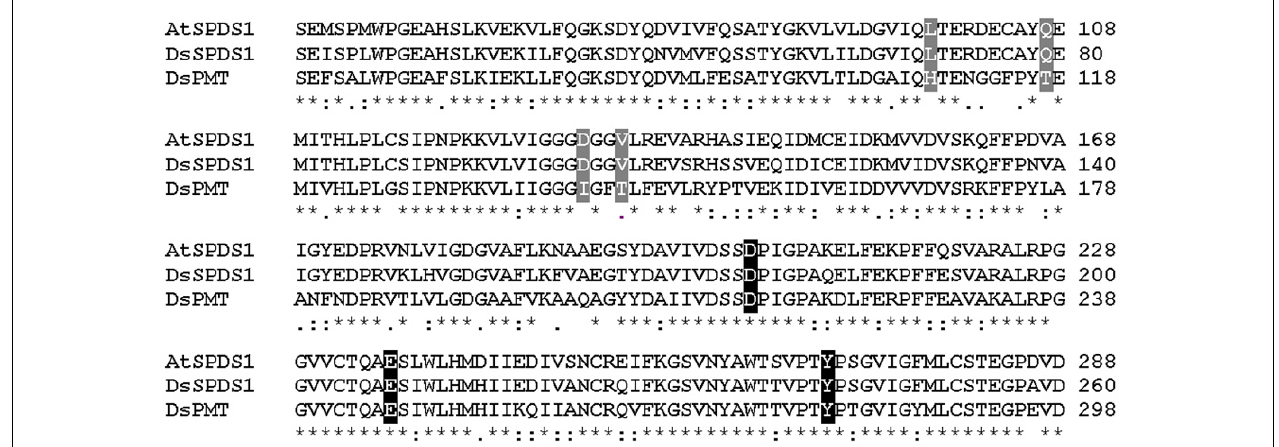
FIGURE 4 | Sequence alignment of wild type enzymes by Clustal W. (Larkin et al., 2007), sequence identities in amino acid sequences: AtSPDS1 to DsSPDS1 82%, AtSPDS1 to DsPMT 60%, DsSPDS1 to DsPMT 67%. Changes by site-directed mutagenesis in coenzyme